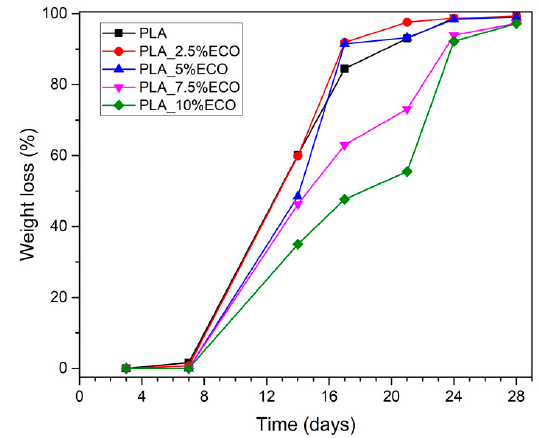
Figure 9. Weight loss recorded during disintegration test.